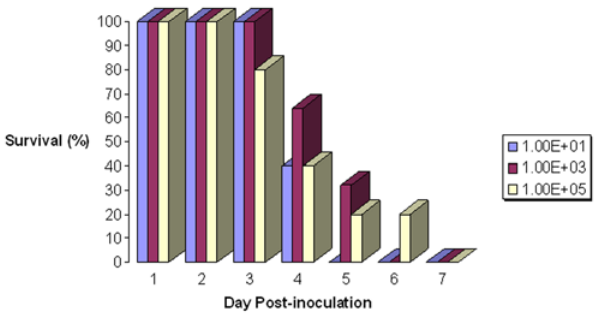
Figure 1. Survival of American kestrels infected with highly pathogenic avian influenza virus H5N1. Daily percentage of American kestrels surviving after infection with one of three doses of highly pathogenic avian influenza virus H5N1 (A/whooperswan/ Mongolia/244/05).